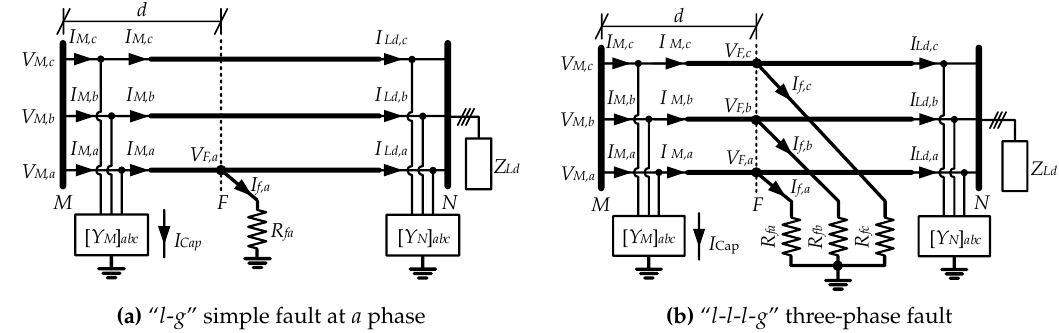
Figure 4. Simplified model of an underground faulted section in the Filomena et al. method